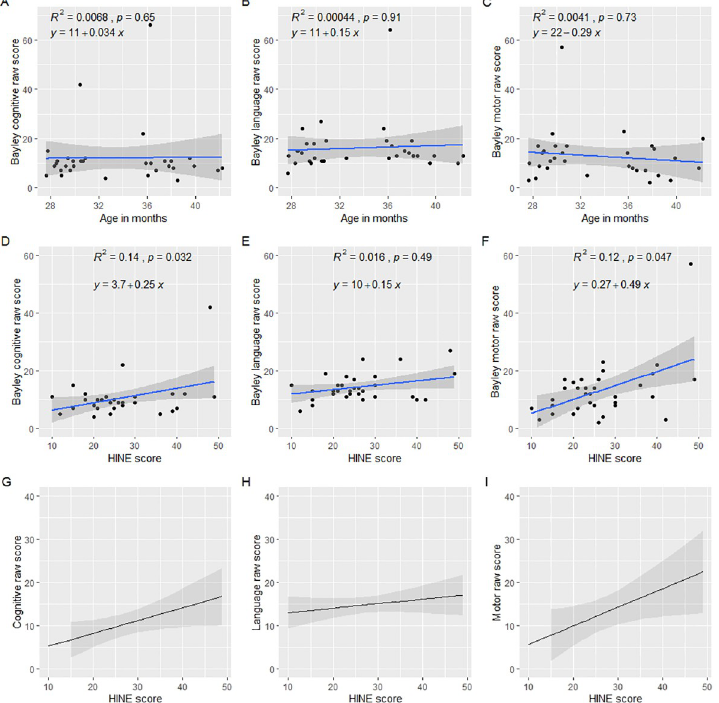
Fig 3. Neurodevelopment of children with Congenital Zika Syndrome-associated microcephaly. Raw Bayley scores over time (A, B, and C). Correlation of raw Bayley scores with the HINE neurological assessment (first section) score (D, E, and F). Linear regression model of the association between HINE score and Bayley raws scores adjusted by prematurity, child age and head circumference (G, H, and I).